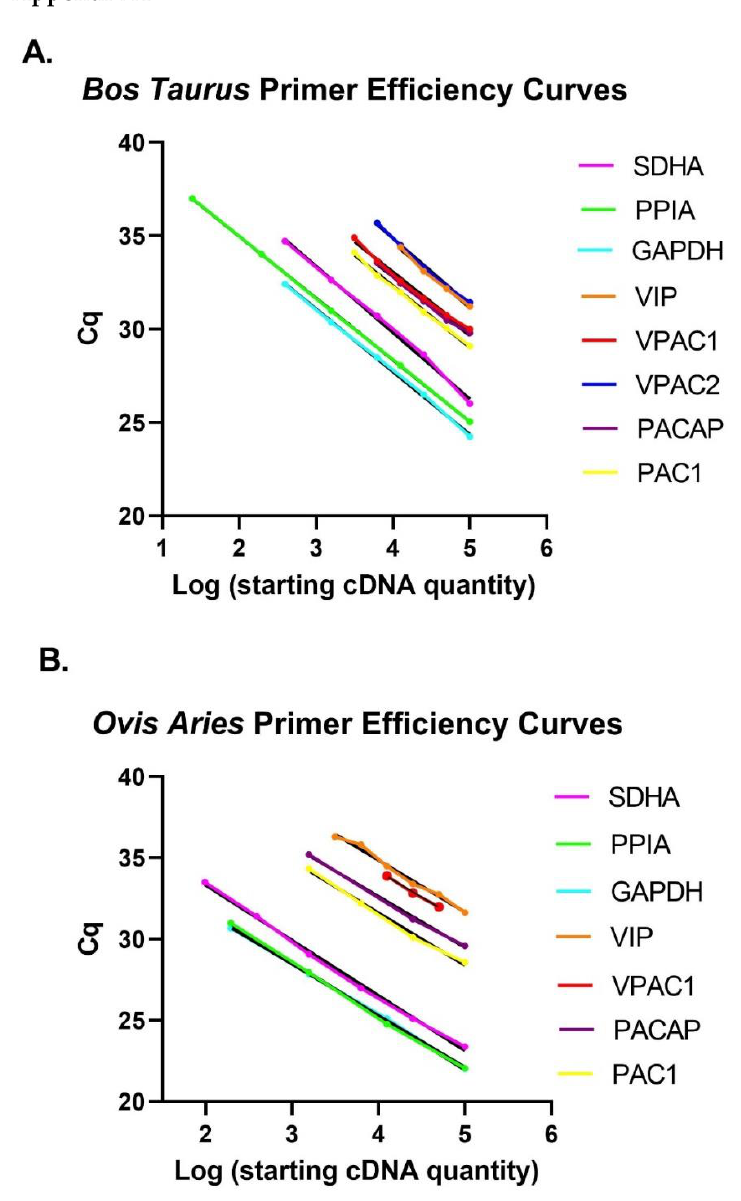
Figure A1. Primer Efficiency Curves. Curves made using ( A ) . Bos Taurus and ( B ). Ovis Aries . Efficien- cies are between 91 – 108%.